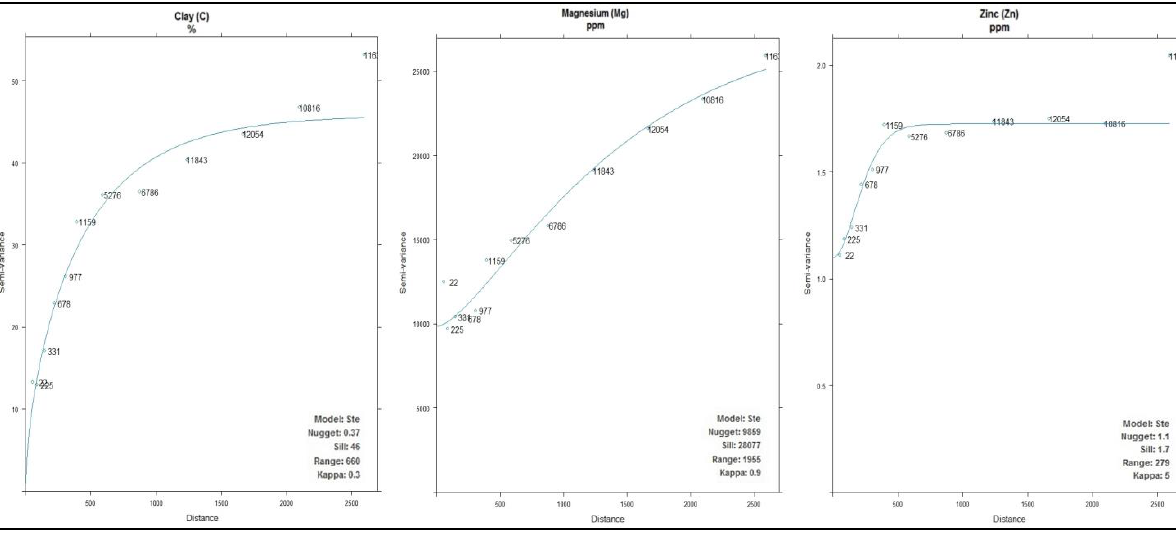
Figure 4. Semivariograms and fitted model of soil covariates of the study area. For all the soil parameters, the Matern semivariogram model with M. Stein ’ s pa- rameterization (Ste) was applied as the fitted model using gstat ’ s default parameters.